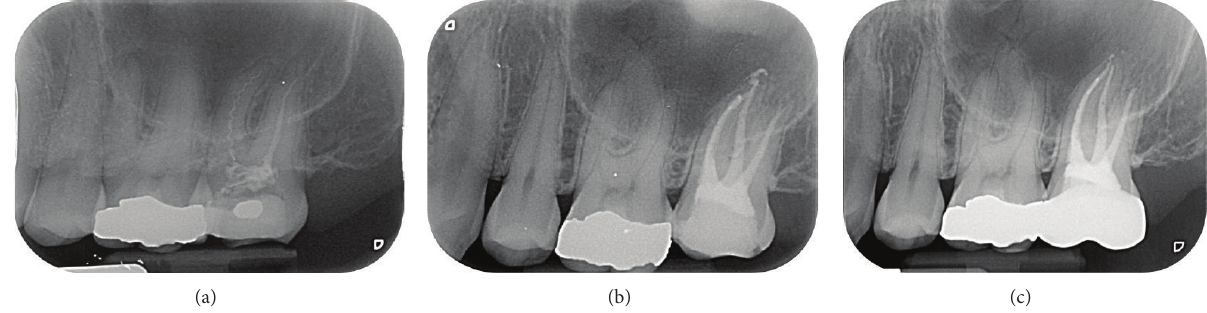
Figure 8: Successful endodontic retreatment of 27 symptomatic, with broken instrument. (a) Preoperative X-ray of a patient sent for orthograde retreatment of 27, painful, with broken instrument (Lentulo) in the mesio-buccal root. The initial treatment was recent. (b) Peroperative X-ray: the broken instrument has been removed and apical patency was found before the cleaning, shaping, and filling of the canal. (c) Recall X-Ray with follow-up for 4 years. Note that lateral radiolucency had disappeared. The tooth is classified as “healed”: absence of symptoms and periodontal